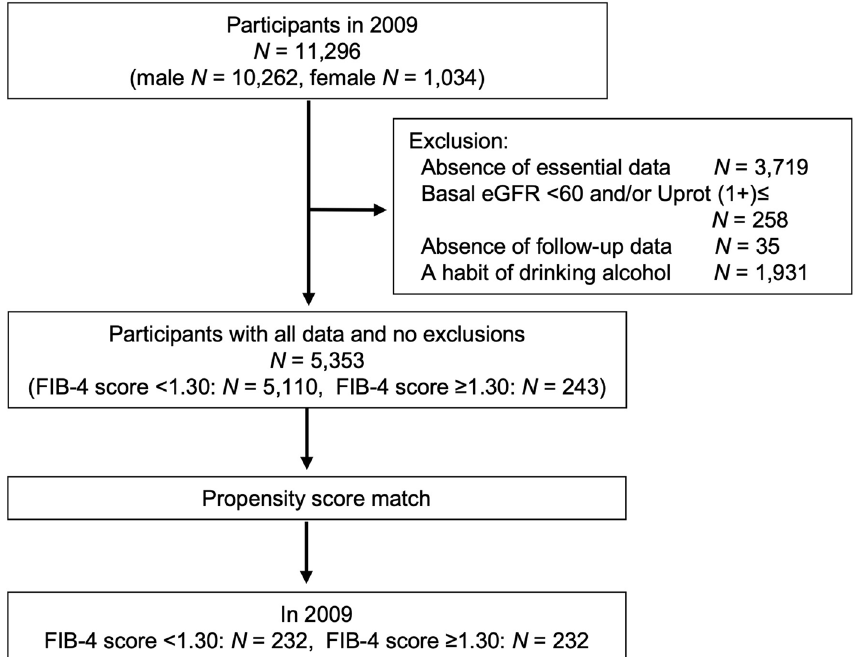
Figure 1. Enrollment, exclusion, and propensity score matching. The data collected included age, body mass index, estimated glomerular filtration rate (eGFR, mL/min per 1.73 m 2 ), transaminase, platelet, lipid profile, hemoglobin A1c, serum uric acid, blood pressure, urinalysis, and self-interview sheet. Participants with missing essential data from the 5-year follow-up were excluded. The habit of drinking alcohol was defined as consumption of ≥ 30 g/day (men) and ≥ 20 g/day (women) of ethanol. In the exclusion criteria process, all women ( N = 1034) were left out, so analyzed participants ( N = 5353) were men only. Uprot; proteinuria with dipstick